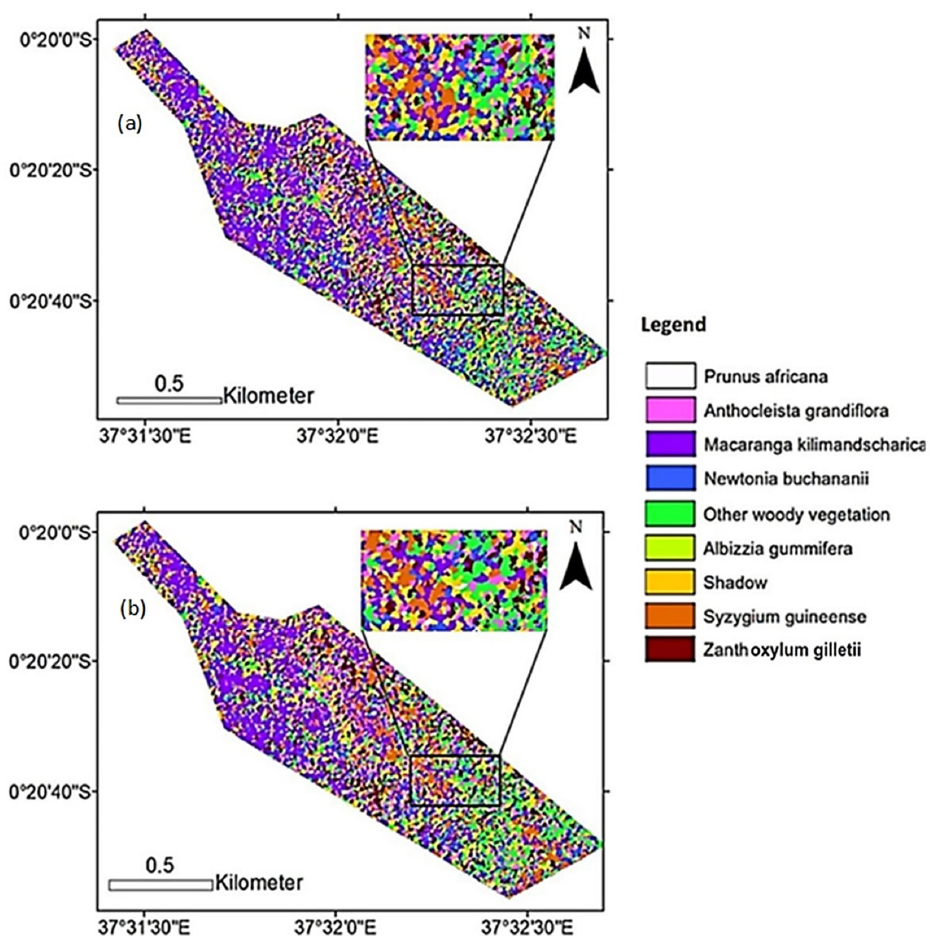
Figure 11. Classification maps of tree species in Mt. Kenya Forest, obtained using ( a ) random forest and ( b ) support vector machine. Table 6. Area coverage in hectares and percentage of the classes using RF and SVM